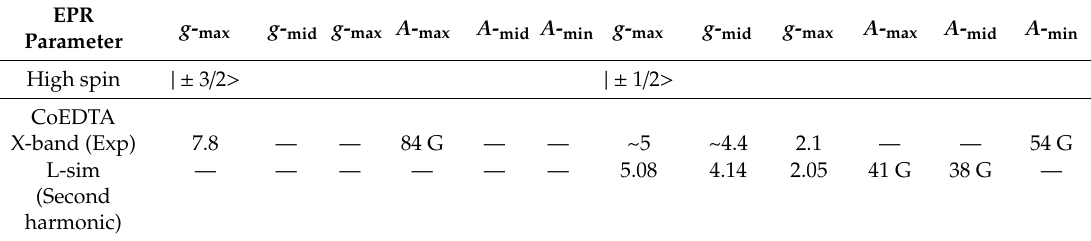
a The g-values are the e ff ective